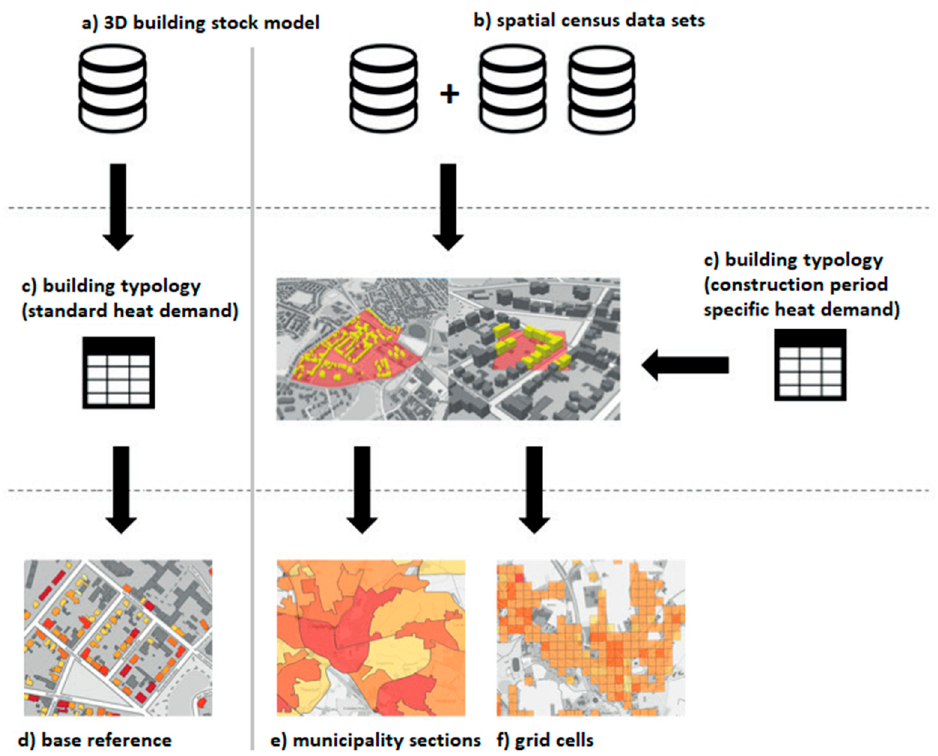
Figure 3. Data processing and method flow schema: the provided 3D building stock model ( a ) and two available spatial census data sets ( b ) were combined with building type or construction period specific standard heat demand values from a regional building typology ( c ) to create a base reference data set ( d ) and two enhanced data sets ( e , f ) on the heat demand of residential buildings.